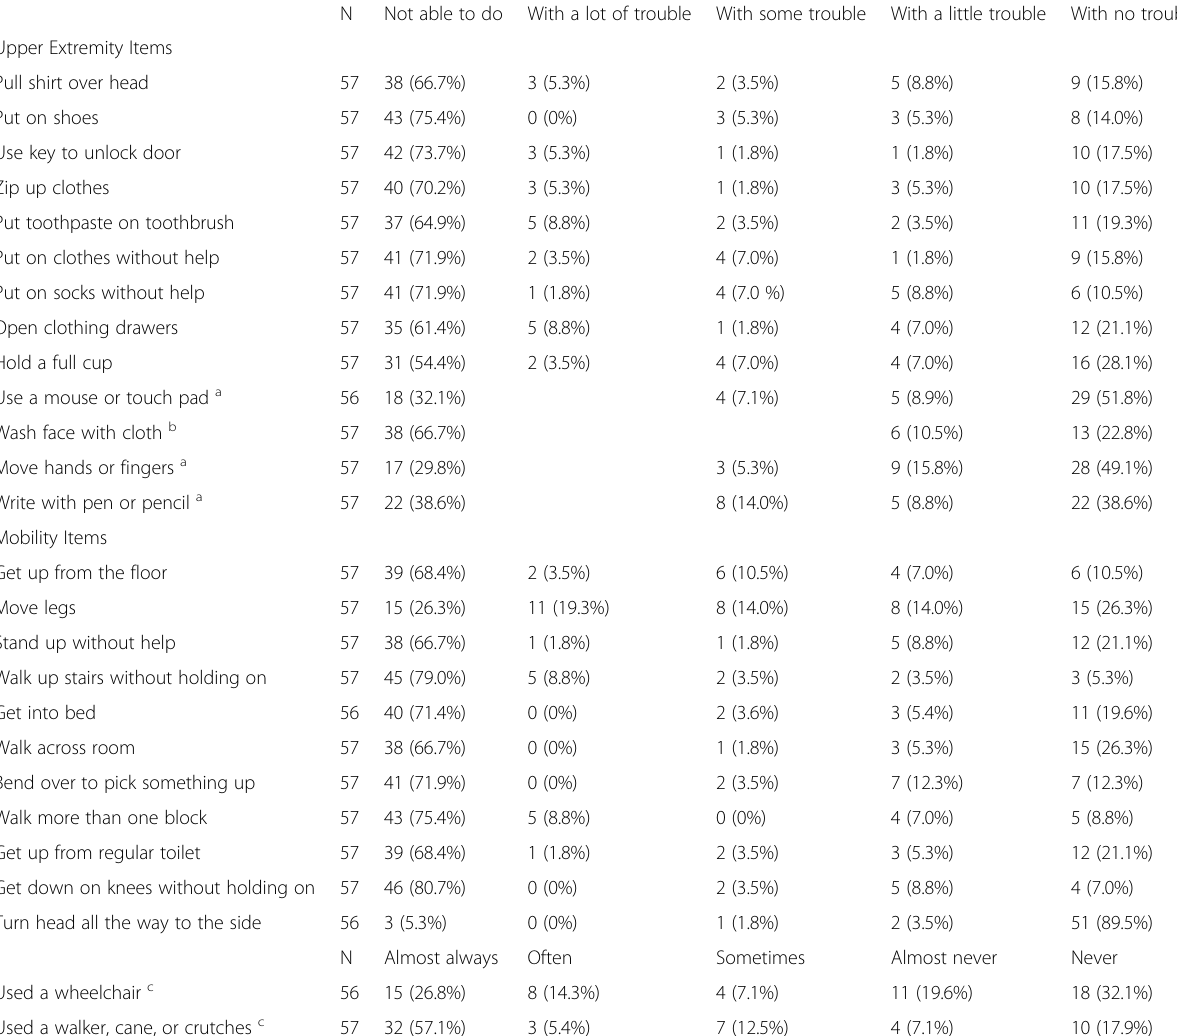
Table 2 Frequencies and percentages of responses to Upper Extremity and Mobility items N Not able to do With a lot of trouble With some trouble With a little trouble With no trouble Upper Extremity